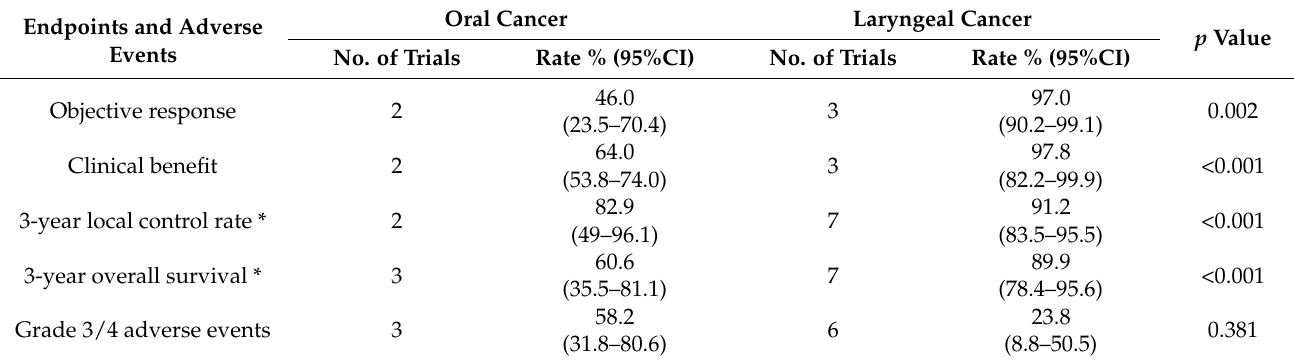
Table 2. Subgroup analysis of standardized mean differences based on primary